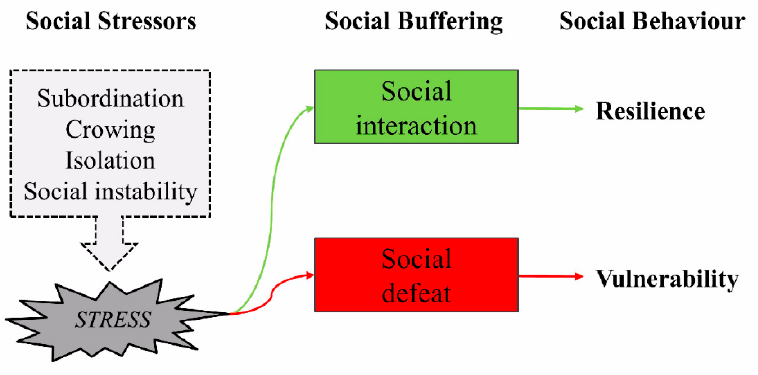
Figure 7. Social Interactions and Social Defeat.